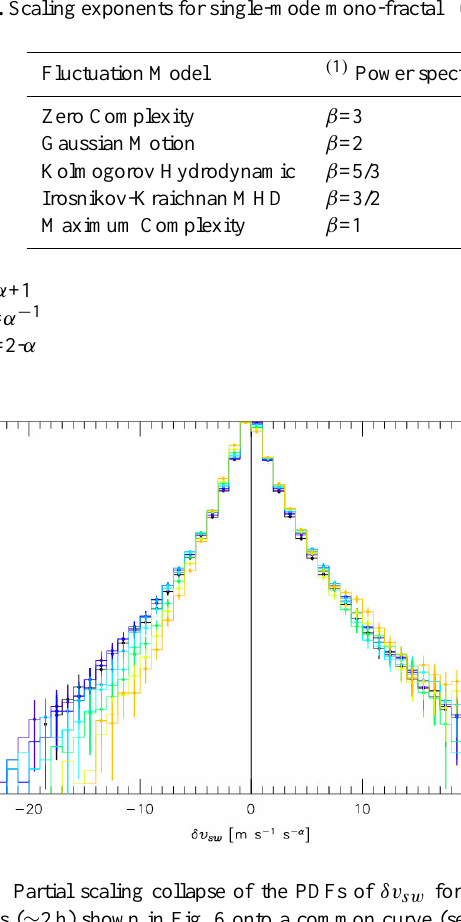
Table 1. Scaling exponents for single-mode mono-fractal fluctuating measures.